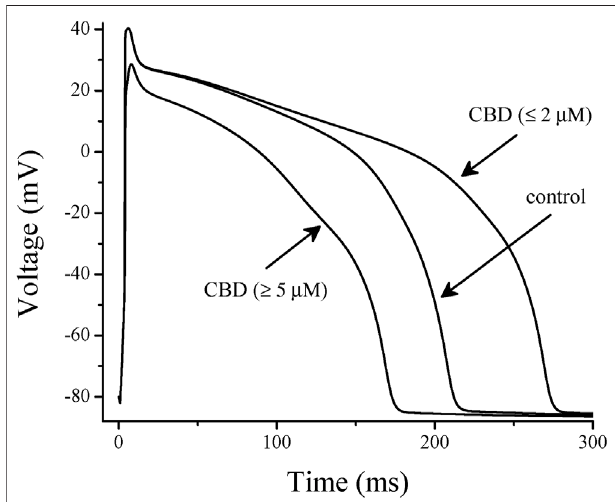
FIGURE 7 | Effects of low and high concentrations of CBD on the simulatedaction potentialsusing LabHEART simulations. Atlow( ≤ 2 µM) CBD concentrations, inhibition of I Kr and I Ks was incorporated into the model. At high ( ≥ 5 µM) CBD concentrations, inhibitions of I Kr , I Ks , I Na , and I L-Ca were incorporated into the model. At low concentrations, CBD induced a marked prolongation (29%) of action potential duration (APD), while at high concentrations, it signi fi cantly shortened (27%) the